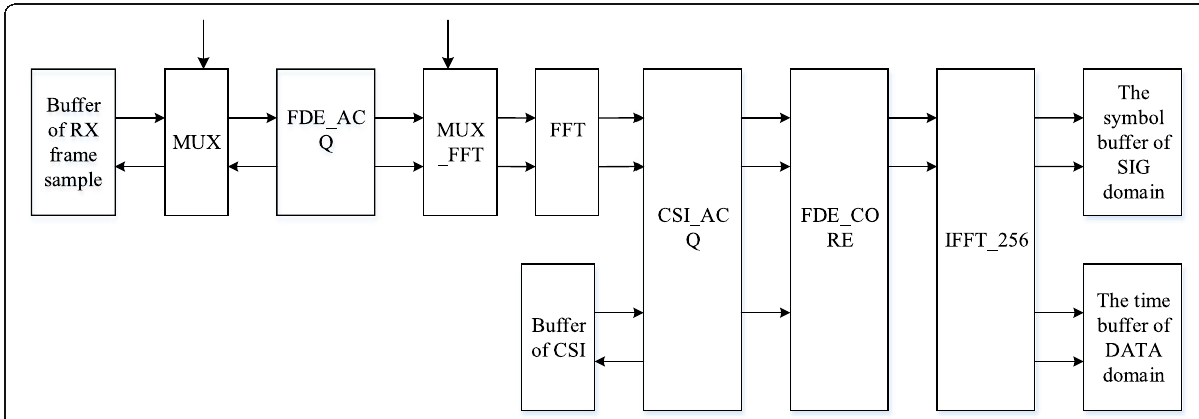
Fig. 9 The hardware implementation block diagram of channel equalization module. The hardware implementation block diagram of channel equalization module. SC-FDE symbols in the time domain are read from “ buffer of RX frame sample ” by the channel equalization module and sent to the FFT module to calculate the frequency domain values of SC-FDE symbols. Frequency domain values are read from “ buffer of CSI ” by the CSI_ACQ module, which can complete the integration of corresponding samples meanwhile. With the complex multiplication of the corresponding sample points completed by the FDE_CORE module, the frequency domain equalization is